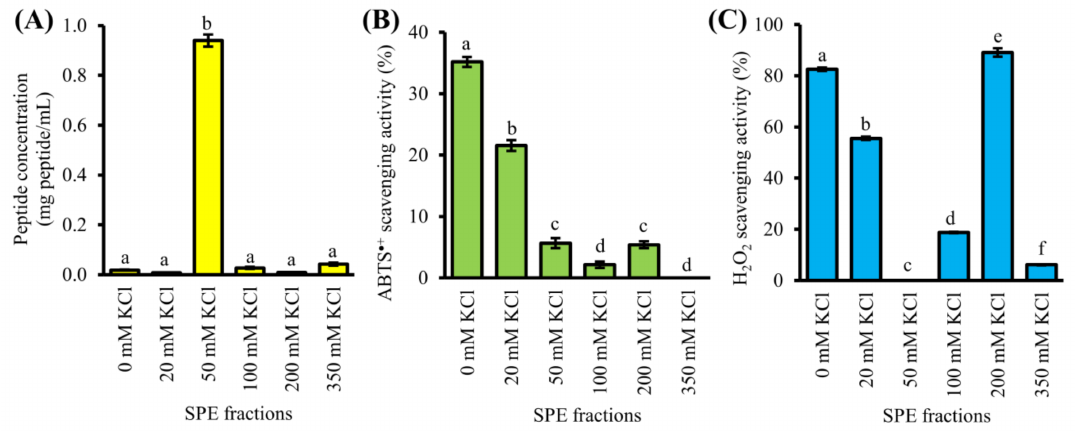
Figure 3. Purification of the GF-III fraction by strong-cation-exchange solid-phase extraction (SPE). ( A ) Peptide concentration, ( B ) ABTS • + scavenging activity (at 0.7 µ g peptide/mL), and ( C ) H 2 O 2 scavenging activity (at 10 µ g peptide/mL) of SPE fractions. Data are mean ± standard errors ( n = 3). For each bar chart, mean values denoted by different superscript letters are significantly different ( p < 0.05) according to Tukey’s